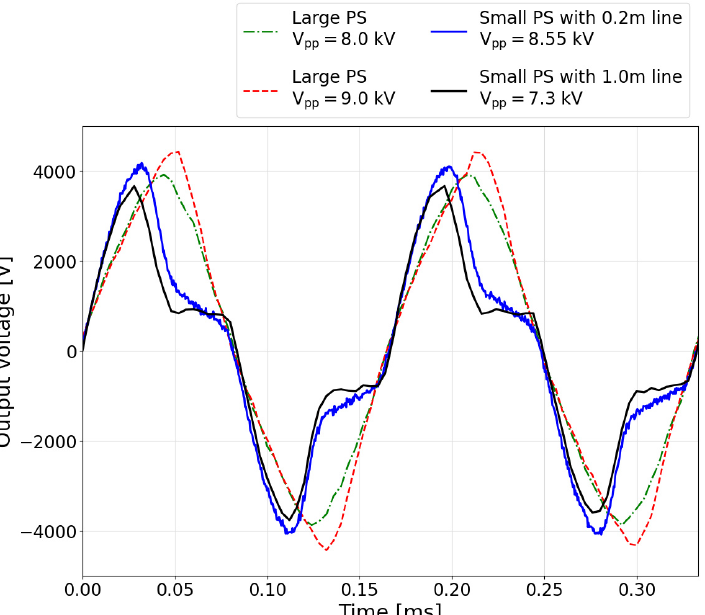
Figure 5. Output waveform from the small HV power supply when a 1 m length DBD-PA was connected. Notably, this small HV power supply cannot configure the output voltage amplitude, and the waveform depends on the circuit